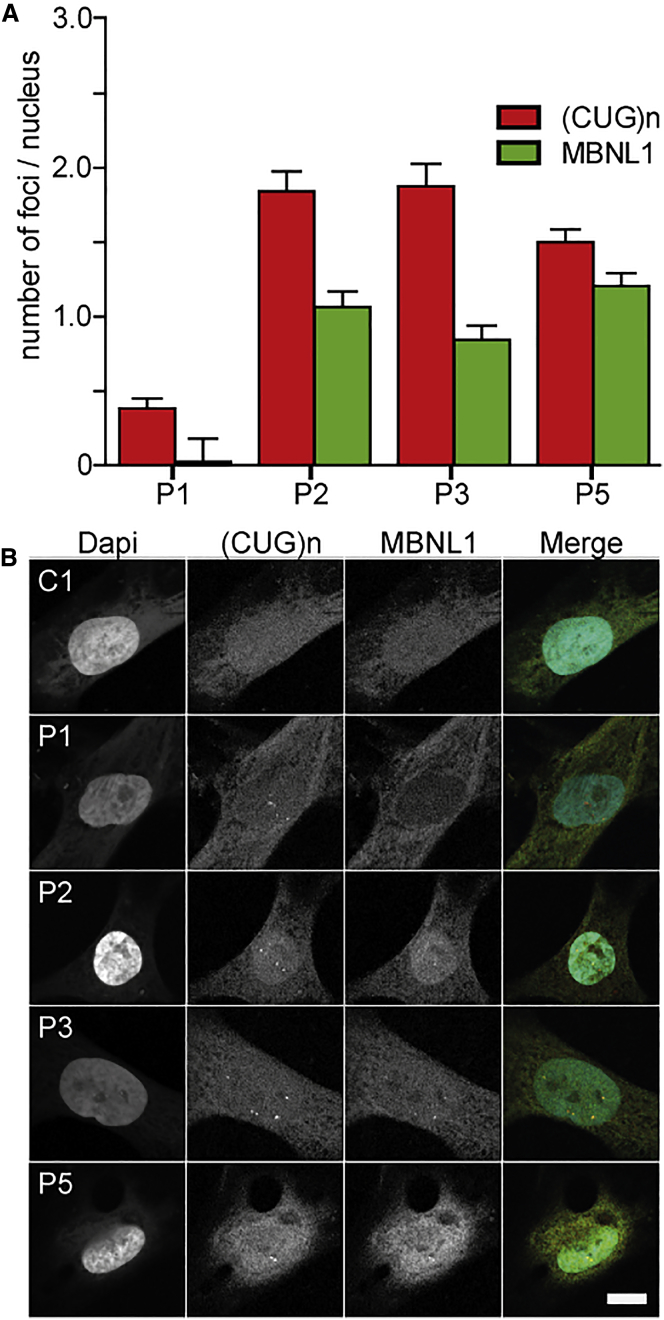
DM1 Foci in DM1 Patient Pericytes(A) Automated quantification of nuclear (CUG)n and MBNL1 foci for P1, P2, P3, and P5. At least 60 nuclei per pericyte population were analyzed. (B) Simultaneous detection of DM1 foci by RNA in situ hybridization using a fluorescent (CAG)6 probe and immunofluorescence using a MBNL1 antibody in human pericytes. Error bars indicate SEM. Scale bar, 10 μm.